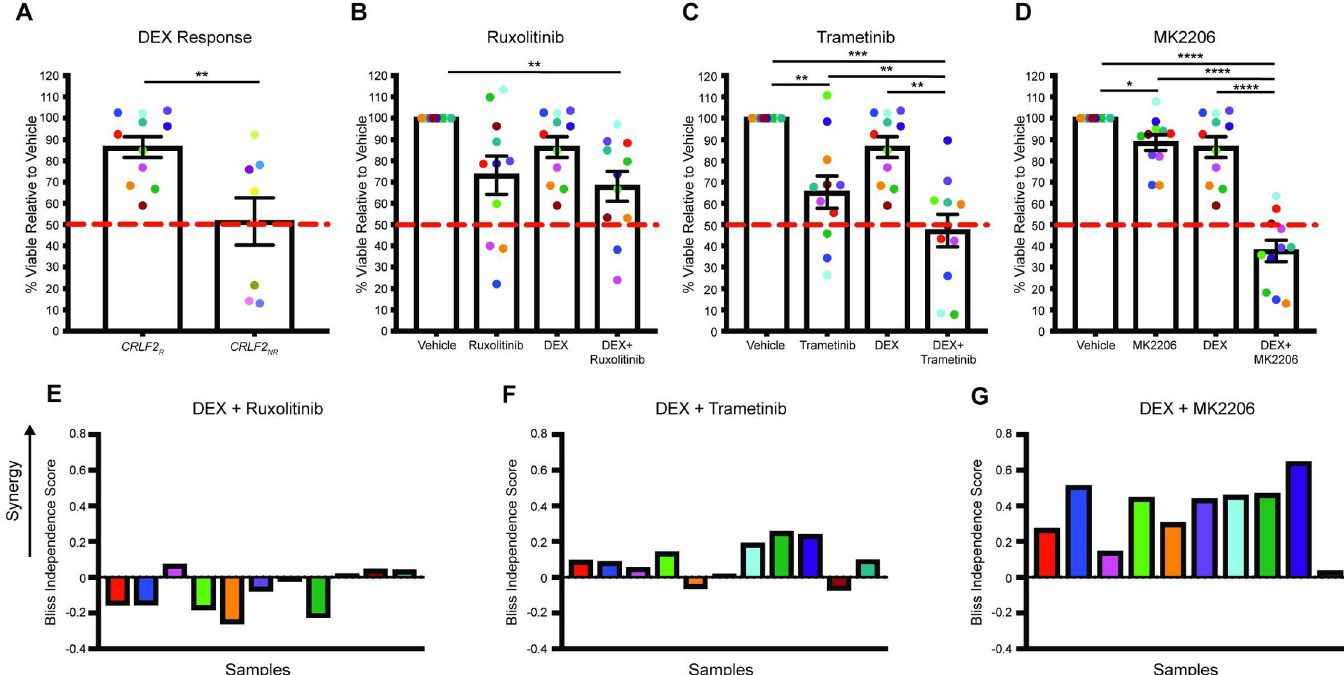
Fig 2. CRLF2 leukemias are uniformly DEX resistant and can be sensitized to DEX with targeted inhibition of MEK or Akt. ( A ) Cell viability in response to 1 μ M R DEX, presented as the percentage of viable cells in the DEX treated condition relative to the vehicle control condition in CRLF2 viability of CRLF2 R samples following exposure to 1 μ M DEX, ( B ) 500nM ruxolitinib, ( C ) 1 μ M trametinib, ( D ) 1 μ M MK2206, or a combination of DEX and a targeted inhibitor presented as the percentage of viable cells in the drug treated conditions relative to the vehicle control condition. (E-G) Bliss independence scores for the combination of DEX and ruxolitinib (E) , trametinib (F) , or MK2206 (G) in CRLF2 R samples, in which positive values indicate a synergistic interaction between the two agents. Error bars represent the standard error of the mean. Statistical significance was assessed using a two-sample t-test (A) or one-way ANOVA with Tukey’s method for multiple comparisons adjustment (B-D). ���� p < 0.0001, ��� p < 0.001, �� p < 0.01, � p < 0.05.